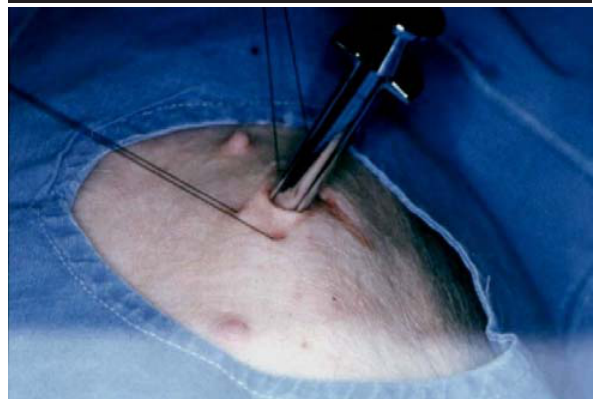
FIGURE 10 - Foley catheter is passed through the lumem of the urological